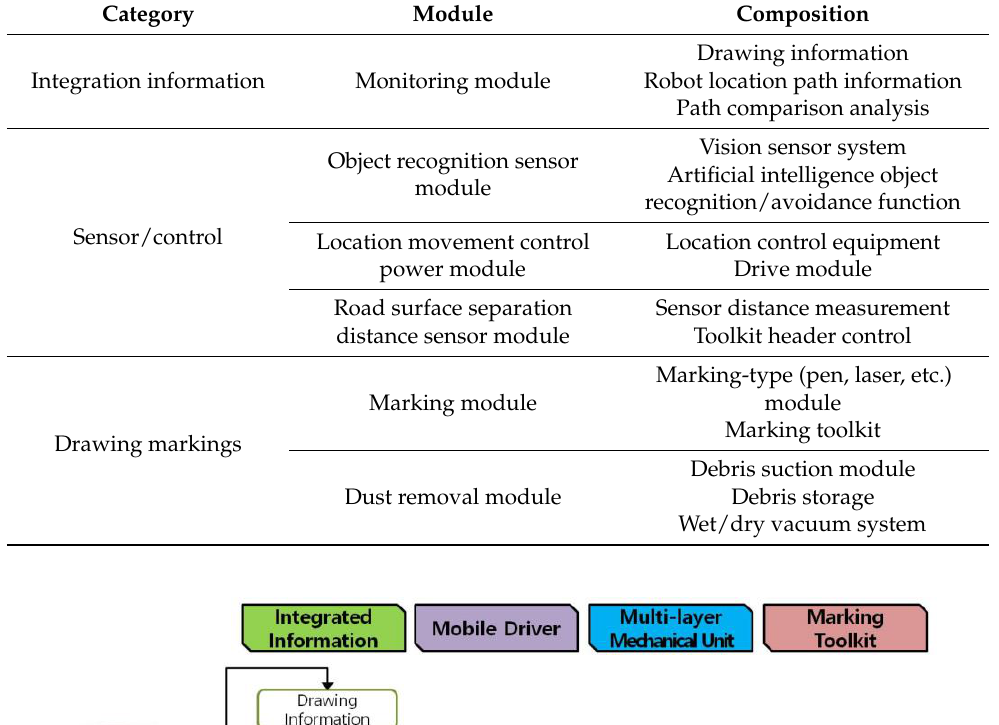
Table 1. Main system modules for layout printing.